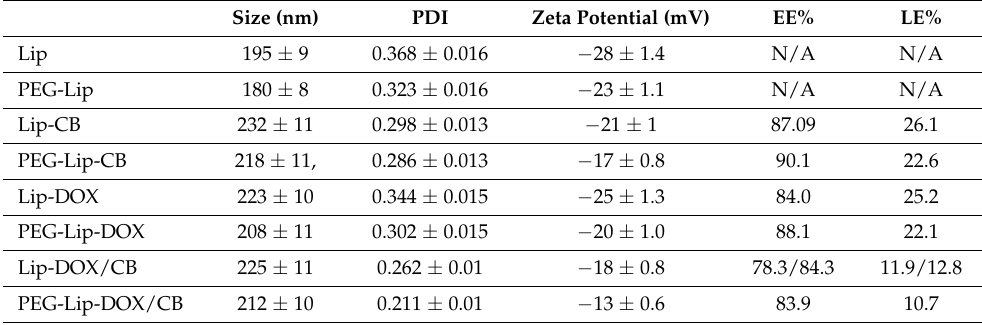
Table 2. Size, polydispersity index (PDI), zeta potential, EE%, and LE% of various nanoparticles obtained by Zetasizer and spectrophotometer